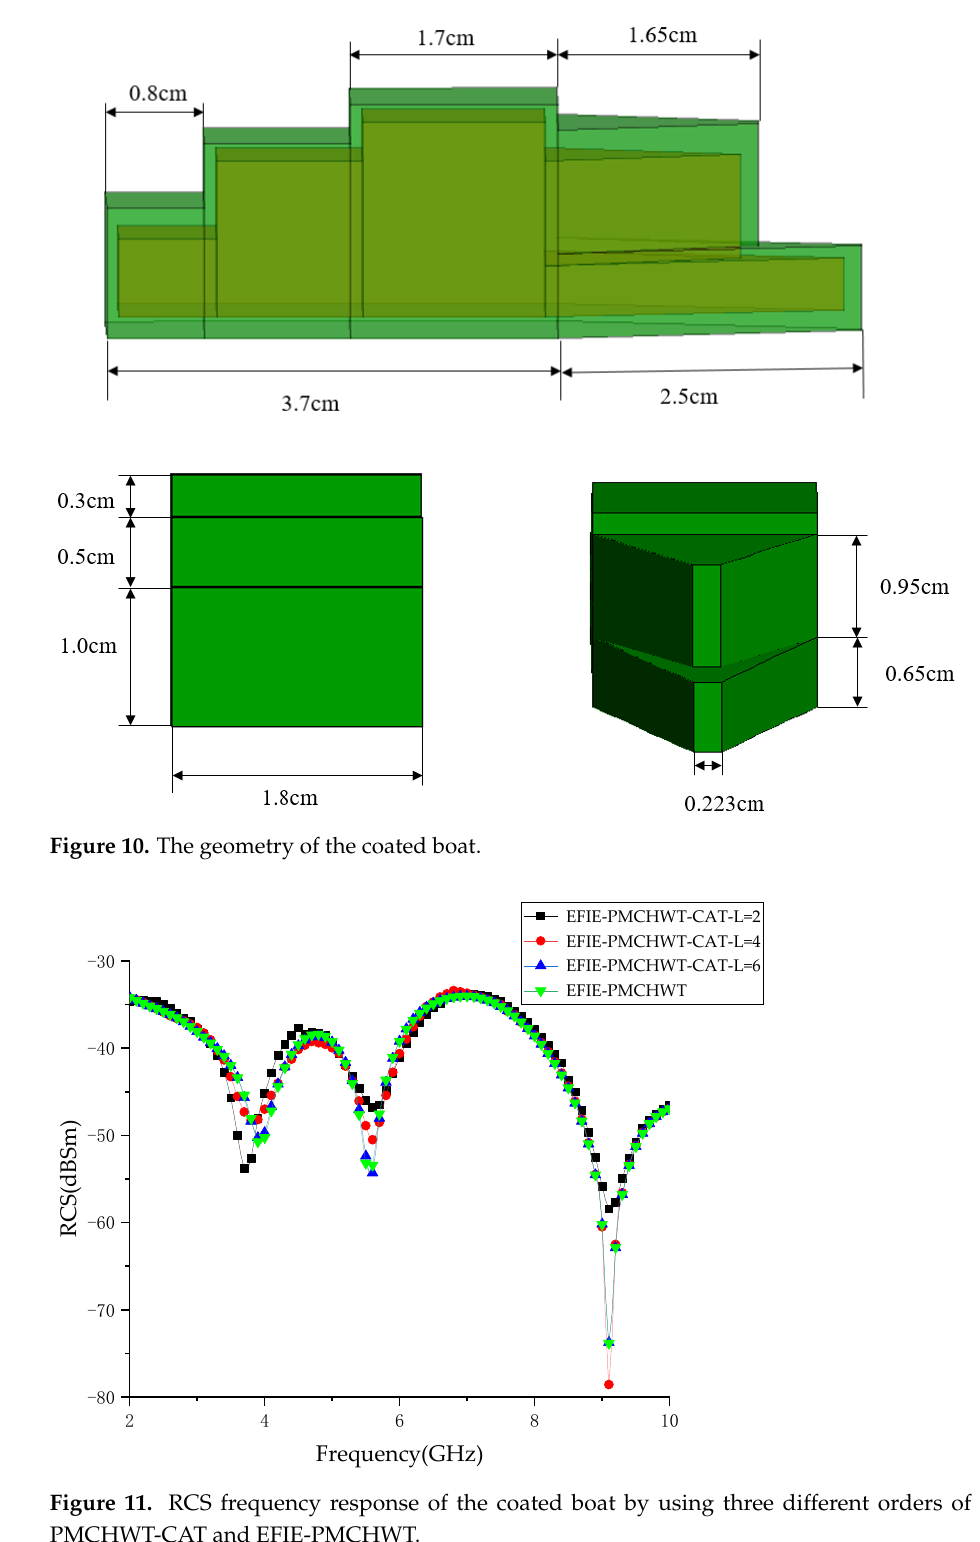
Figure 9. The posture of the coated boat based on Sub6 base station illuminator.